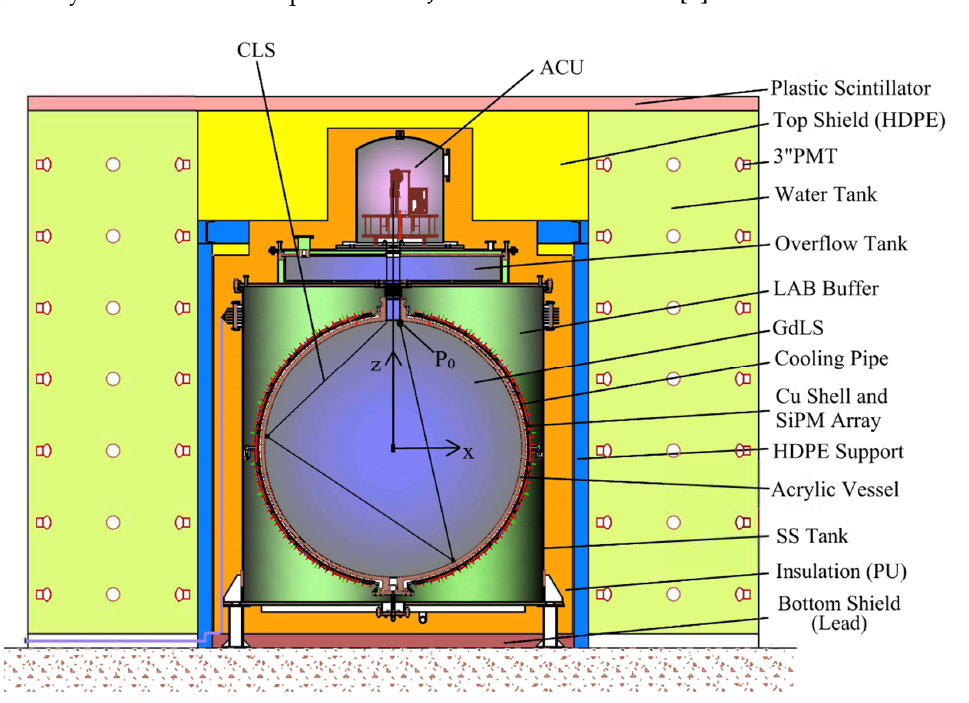
Figure 1. Conceptual design of the TAO detector, which consists of a central detector with the LS neutrino target and a buffer liquid, a calibration system, an outer shielding, and a veto system. The ambient and cosmogenic background will be reduced by the veto system based on plastic scintillator detectors. Layers of high-density polyethylene (HDPE) and polyurethane (PU) will act as passive shielding. A water tank equipped with PMTs acts as a surrounding water Cherenkov detector. The buffer vessel containing LAB and the inner detector (1.8 m acrylic vessel) filled with 2.8 tons of novel